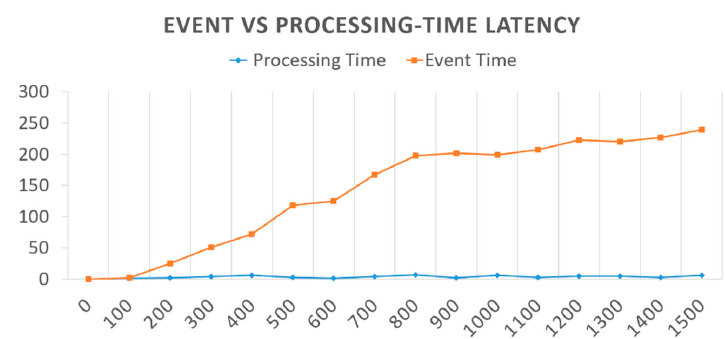
Figure 14. Event time vs. processing time latencies under conditions where the system is extremely overloaded with the incoming workload. overloaded with the incoming